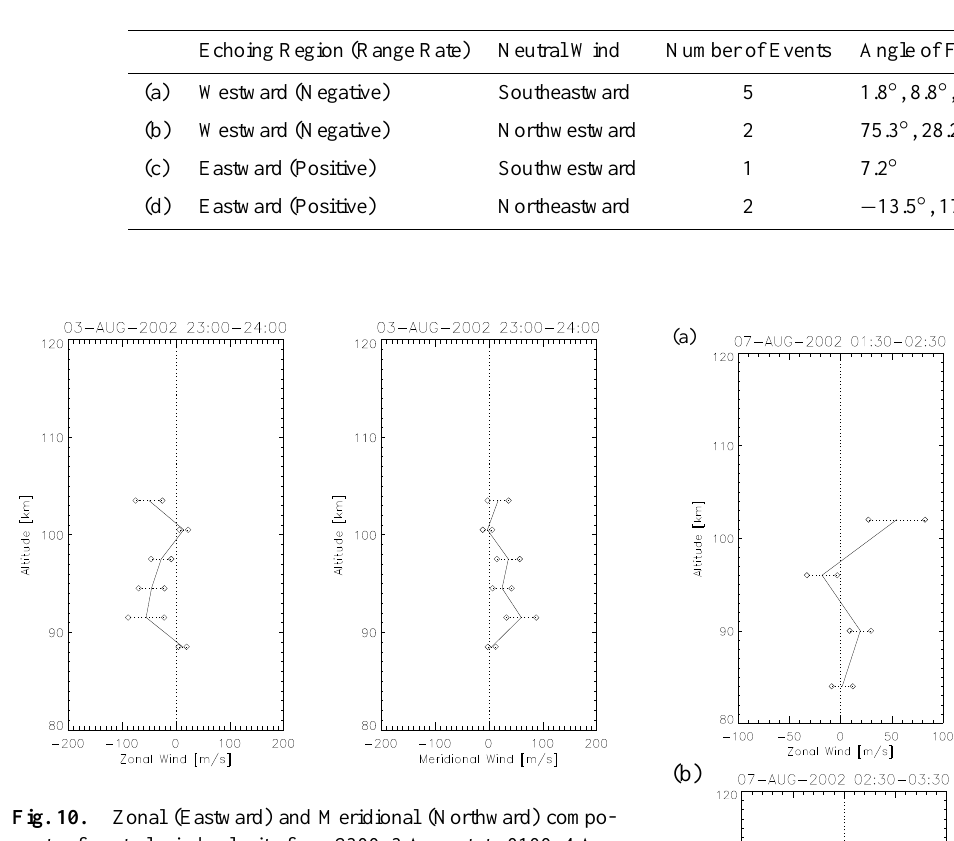
Table 3. Relationship between direction of motion of echoing region and neutral wind and estimated directions of normal vectors of wavefronts. Angle is measured anti-clockwise from geographic east.